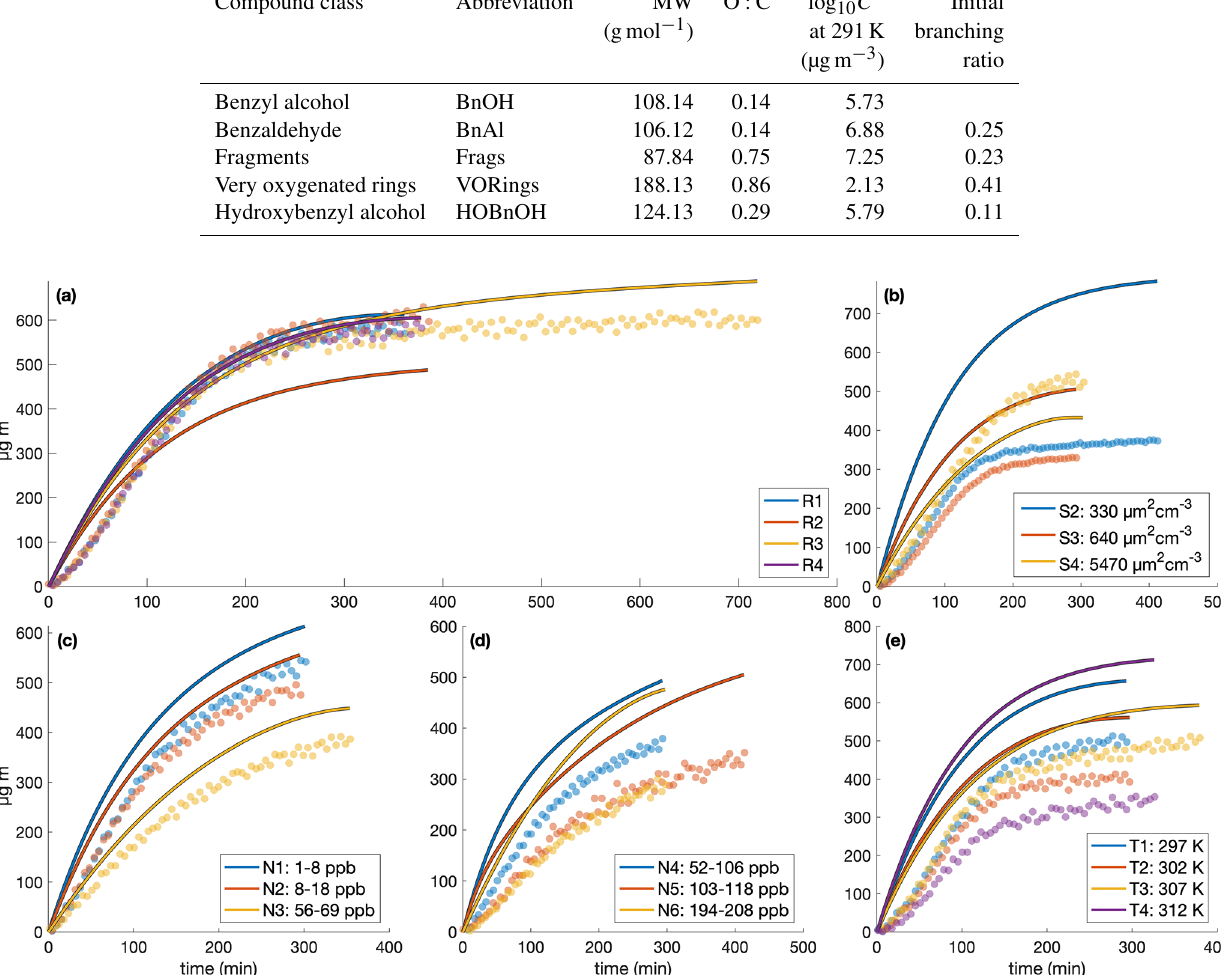
Figure C2. Comparison of measured (circles) and simulated (curves) secondary organic aerosol mass concentrations for different initial surface area concentrations assuming no vapor-wall deposition for the (a) similar experiments, (b) different surface area experiments, (c) low constant NO concentrations, (d) high constant NO concentrations, and (e) different temperature experiments. The decay of benzyl alcohol was simulated using a second-order exponential fit to the data. The accommodation coefficient of vapor to suspended particles α p = 1. Also, α pw = 0 and C w = 1 × 10 4 µgm 3 . Simulation time steps were taken as